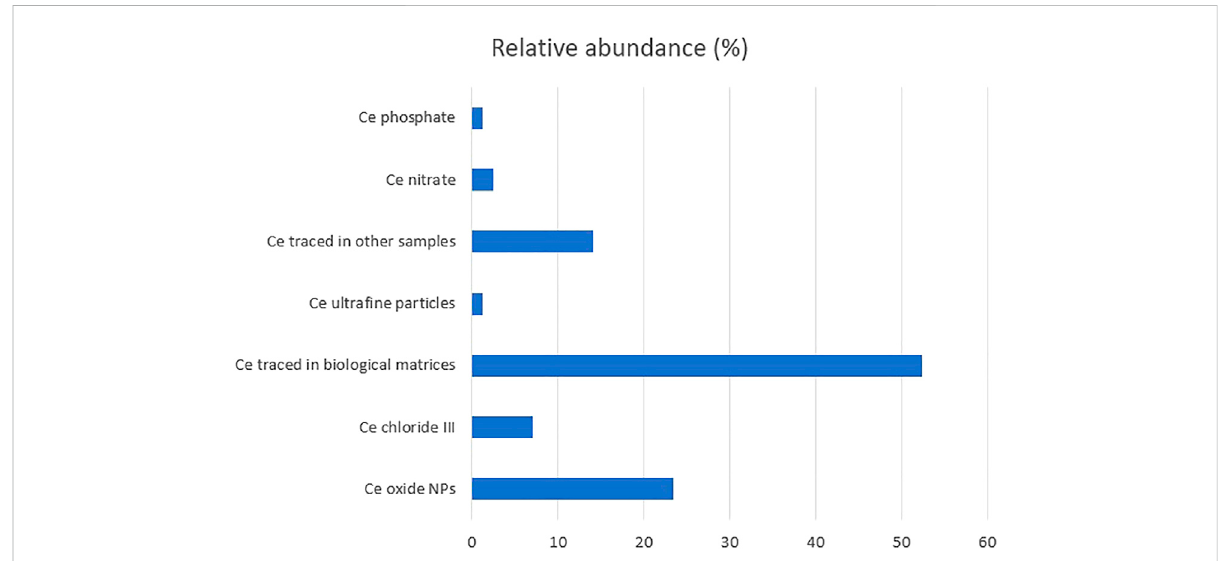
FIGURE 4 Comparison of the relative abundance (%) of each type of Ce studied about its toxicity to human